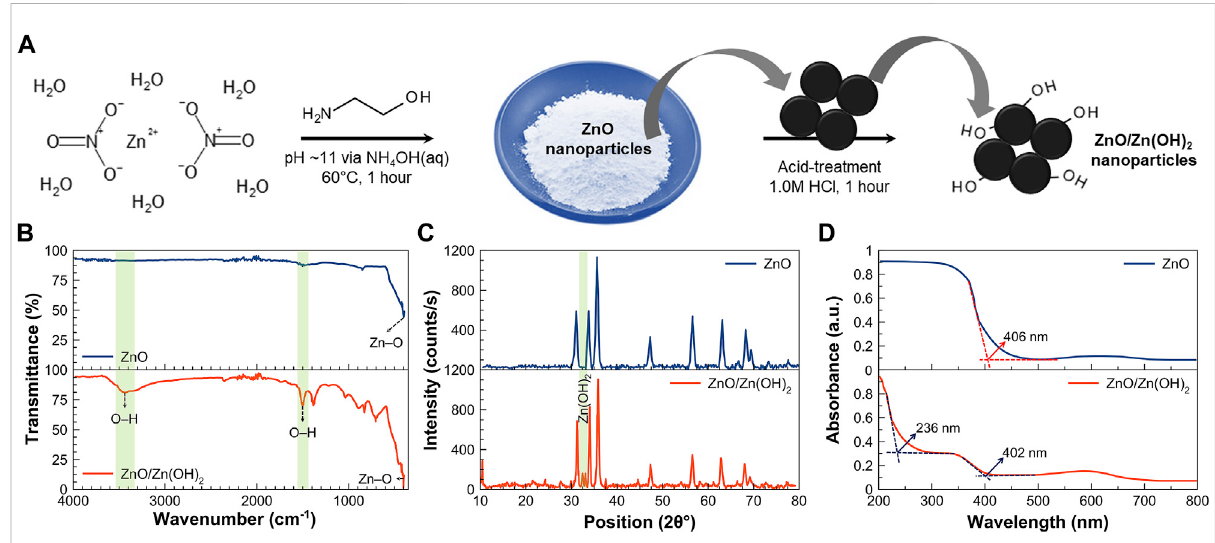
FIGURE 1 (A) A schematic showing the formation of ZnO and ZnO/Zn(OH) 2 nanoparticles. (B) Fourier-transform infrared spectra, (C) X-ray diffraction patterns,and (D)